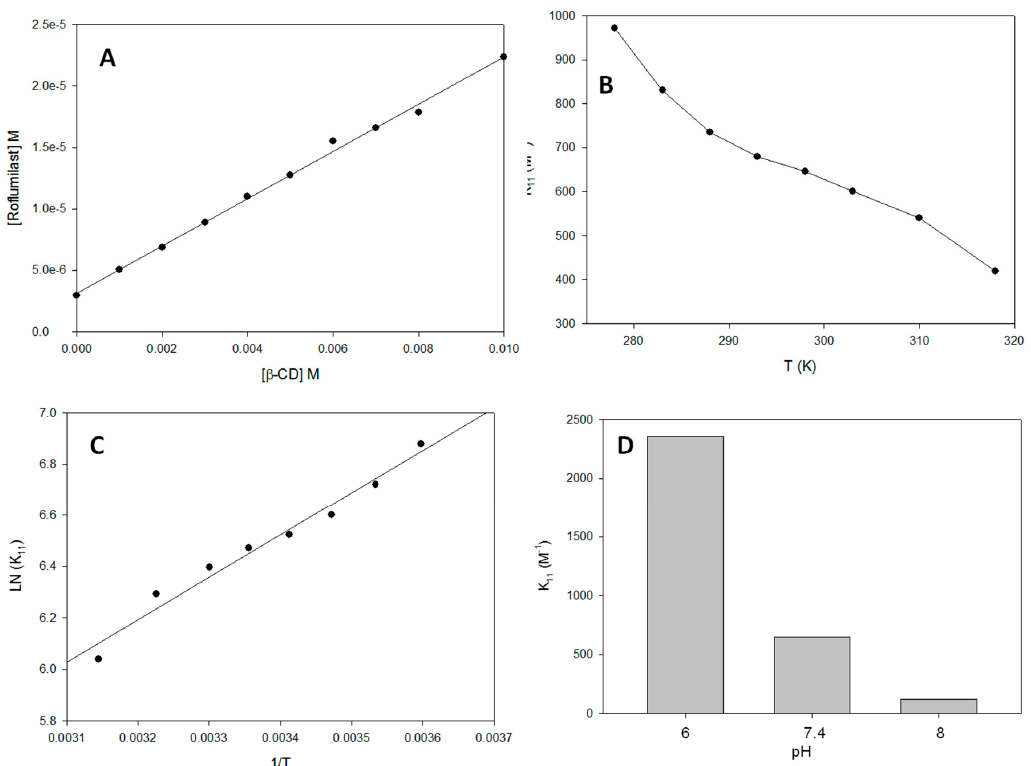
Figure 2. ( A ) Effect of β -CD (cyclodextrin) concentration on roflumilast solubility at pH 7.4 25 °C. ( B ) Effect of temperature on K 11 values for roflumilast and β -CD complexes at pH 7.4. ( C ) Van’t Hoff plot. ( D ) Effect of pH on K 11 values for roflumilast and β -CD complexes at 25 °C. Table 1. Apparent K 11 values and SD for Higuchi and Connors method (1:1 complex). Β -CD M β -CD HP β -CD γ -CD α -CD K11 (M − 1 ) 646 418 329 300 143 SD ( ±